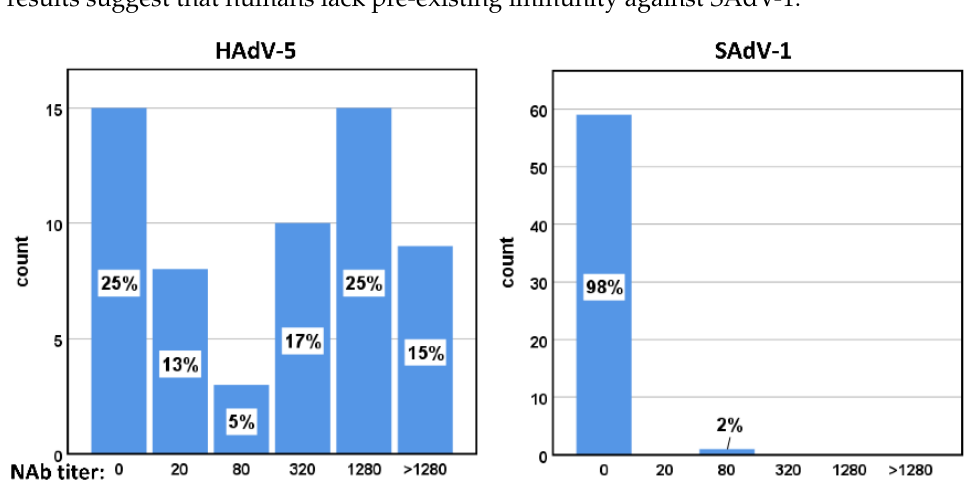
Figure 8. Overall distributions of adult serum samples according to neutralizing antibody (NAb) titers ( n = 60). Human sera were serially diluted, and the highest dilution of serum which could inhibit more than 50% activity of the virus was defined as the NAb titer. A titer of <20 was defined as negative. The y-axis represented the number of samples, while the proportions of samples with indicated NAb titer were shown inside each bar.